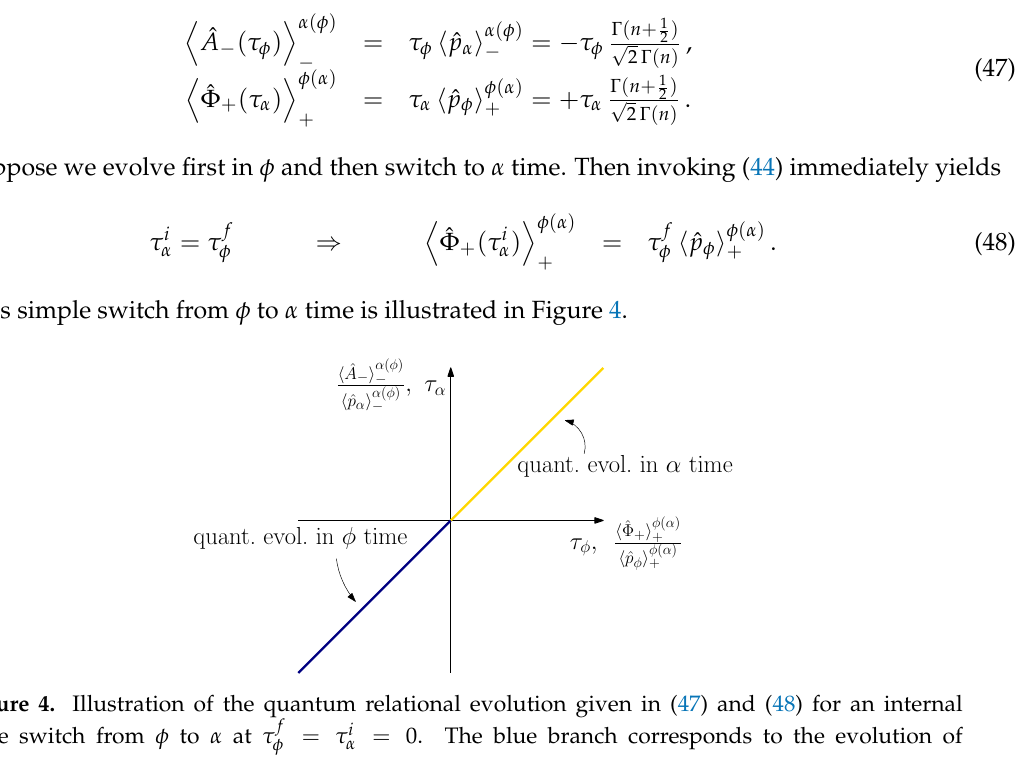
(cid:68) (cid:69) φ ( α ) ( α ) ˆ Φ + ( τ / (cid:104) ˆ p φ (cid:105) φ α ) + +